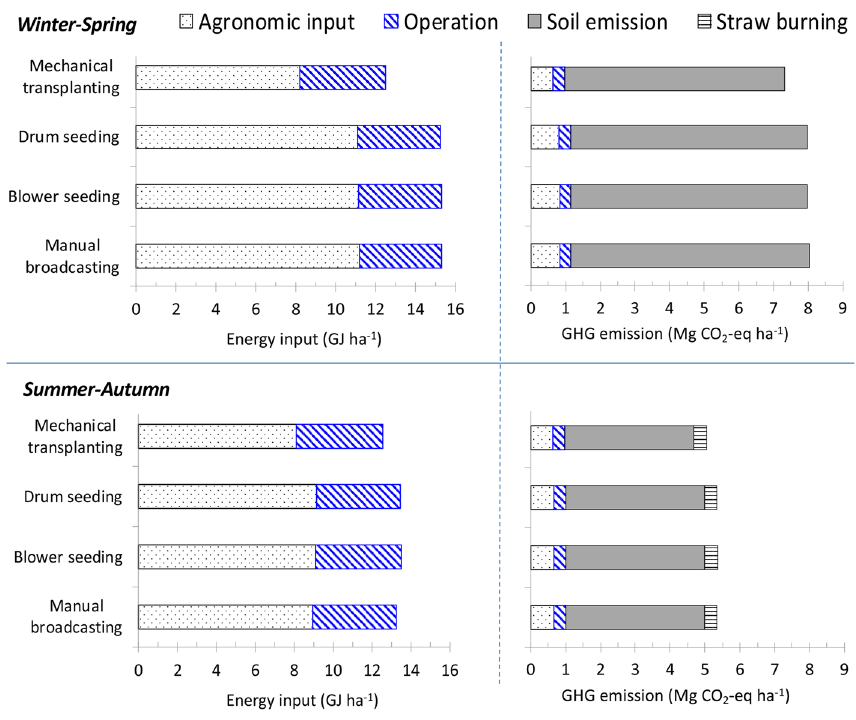
Figure 4. Energy input, GHGEs and production costs for rice production applied with 1M5R under different crop establishment options in Can Tho,